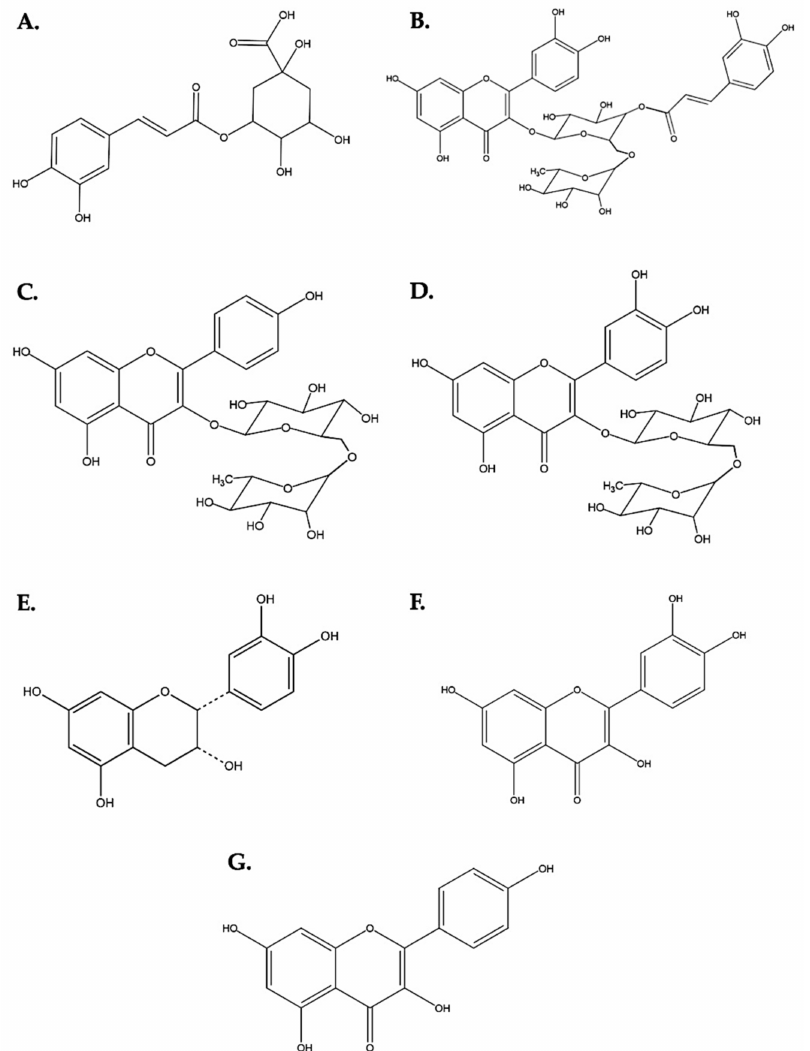
Figure 8. Chemical structures of the flavonoids present in DME and PME. ( A ) 3-O-caffeoylquinic acid (chlorogenic acid). ( B ) Quercetin-3-O-(4” (cid:48) -O-caffeoyl)-rhamnopyranosyl-(1 → 6)-galactopyranose. ( C ) Kaempferol 3-O-rhamnopyranosyl-(1 → 6)-glucopyranose. ( D ) Quercetin 3-O-rhamnopyranosyl- (1 → 6)- glucopyranose (rutin). ( E ) Epicatechin. ( F ) Quercetin. ( G )